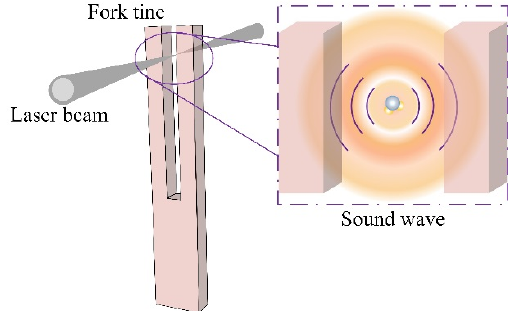
Figure 1 . The schematic diagram of a quartz tuning fork (QTF), the laser excitation beam, and the generated sound wave.